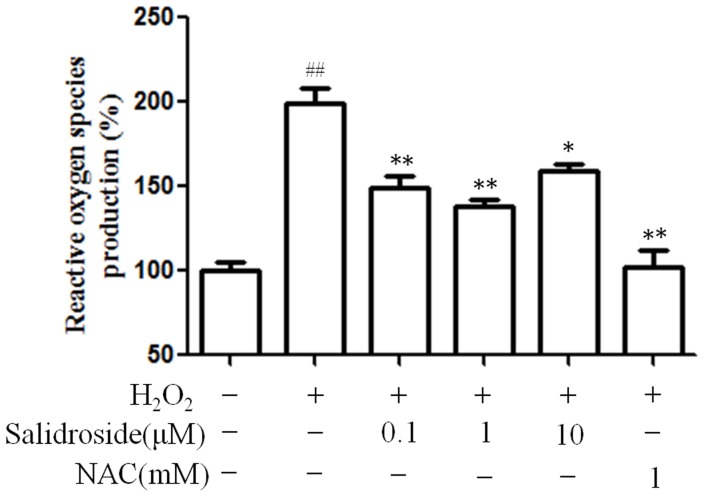
Inhibition of salidroside on reactive oxygen species generation induced by H2O2 in MC3T3-E1 cells.After differentiation induction of 6 days, MC3T3-E1 cells were pretreated with salidroside for 24 h before treatment with 0.3 mM H2O2 for 24 h. NAC was used as positive control. The data shows changes in levels of ROS, which was measured by DCF fluorescence method. ##
P<0.01 versus untreated control cells;*P<0.05 and **P<0.01 compared with the group treated with H2O2 alone.